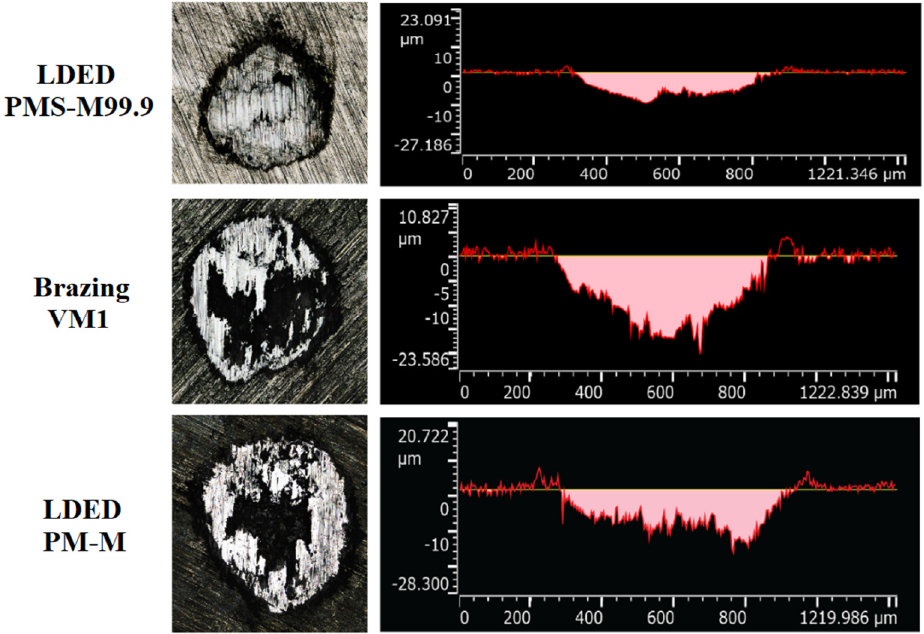
Figure 14. Contact area and the restored cross-section of the wear spot. Table 7. Volumetric wear values of Mo layer after fretting wear tests ( µ m 3 ).